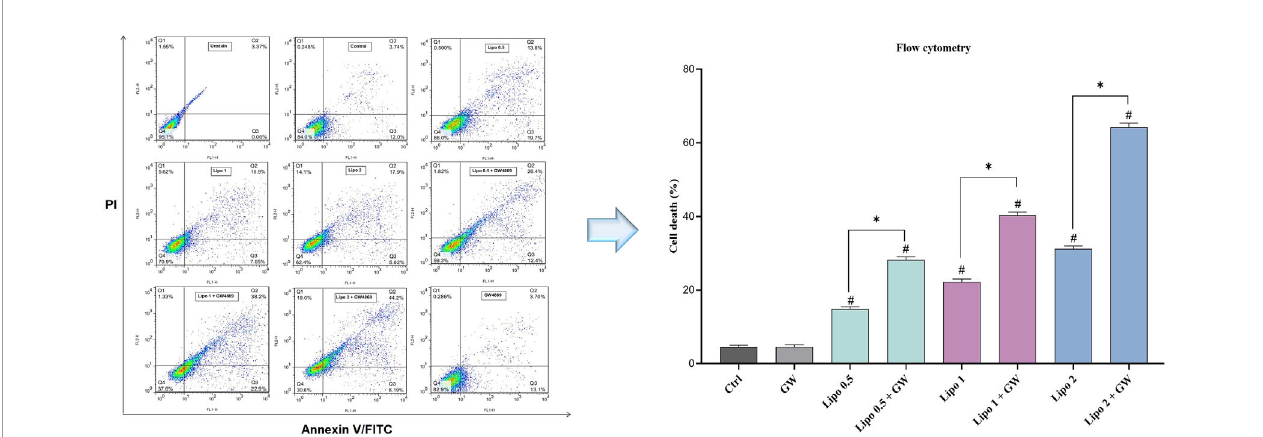
FIGURE 5 | Flow cytometry analysis of cell death in PLD-treated U937 cells in different groups. The graphs represent cell populations undergone complete cell death, which were identi fi ed as the sum of PI single positive plus annexin V/PI double-positive populations in each group. Based on the results, co-treatment of U937 cells with GW4869 in addition to different concentrations of PLD could increase its cytotoxicity compared to the corresponding concentrations without GW4869. Sole GW4869 treatment did not have any signi fi cant effects on the viability of U937 cells compared to the untreated control (P > 0.05). Ctrl, untreated control; GW, GW4869-treated; Lipo 0.5, 0.5 µM PLD; Lipo 0.5 + GW, 0.5 µM PLD with GW4869; Lipo 1, 1 µM PLD; Lipo 1 + GW, 1 µM PLD with GW4869; Lipo 2, 2 µM PLD; Lipo 2 + GW, 2 µM PLD with GW4869. # Signi fi cantly different compared to the control group (P < 0.05), *signi fi cantly different compared to the same concentration with/without GW4869 (P < 0.05).